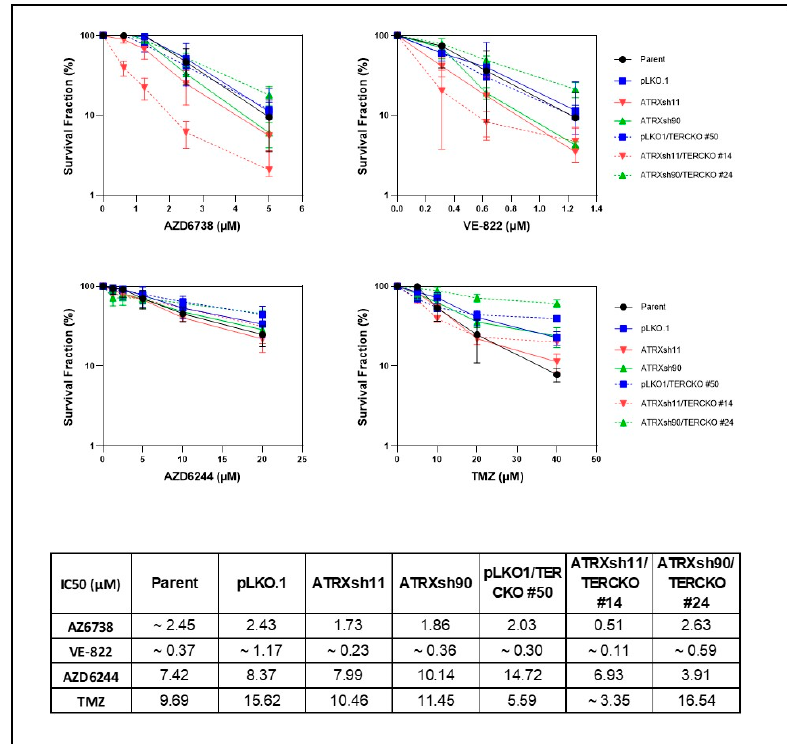
Figure 7. ATRX and TERC loss impairs growth of the MPNST cell line NF90-8 when treated with ATR inhibitors. MPNST cell clones with concurrent ATRX knockdown and TERC knockout are sen- sitive to ATR inhibitors AZD6738 and VE-822, but not to MEK inhibitor (AZD6244) or te- mozolomide. IC50 of drugs are listed at the bottom. Finally, we investigated the effect of ATR inhibition and temozolomide treatment on orthotopic glioma xenografts in vivo. Oral administration of the ATR inhibitor, AZD6738, decreased growth transiently in ATRX-deficient U251 xenografts, while the combination of temozolomide plus AZD6738 had a more pronounced and persistent inhibitory effect on tumor cell growth (Figure 8).